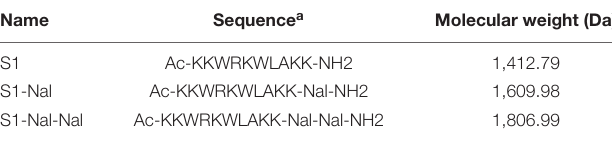
TABLE 1 | Sequences of S1, S1-Nal, and